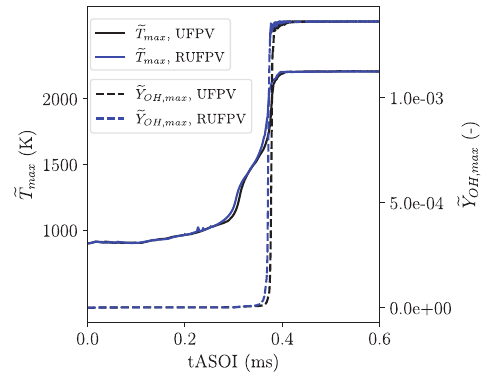
Fig. 11. Distribution of the progress variable source term obtained using the original UFPV-LES approach _ x UFPV with the differences between the source term obtained from the RUFPV FLUT in the a-priori analysis and that of UFPV-LES approach e for 0.40 ms ASOI.